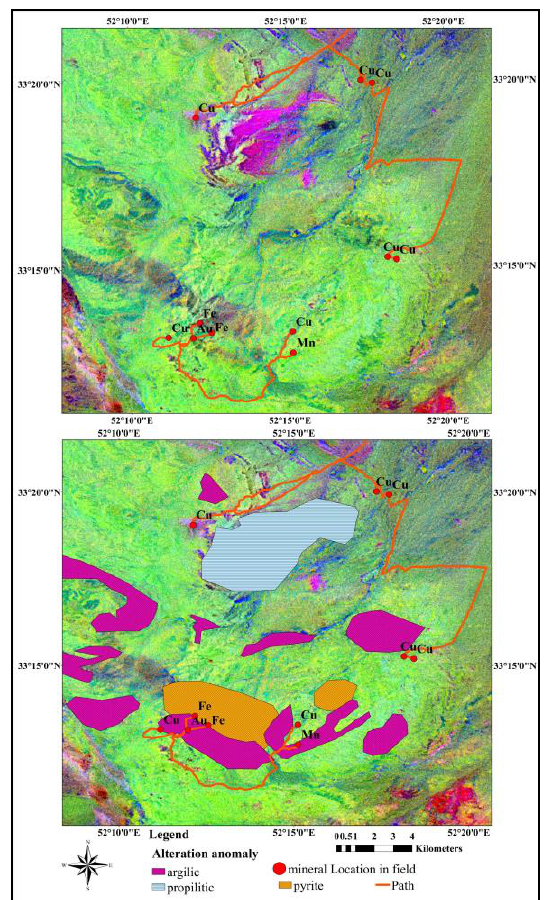
Figure 11. Geological validation of remote sensing results in localization of mineral zones. A) Field observation path on RGB color composite of IC 2, 3 and 6 image. B) Location of alteration zones revealed in PCA